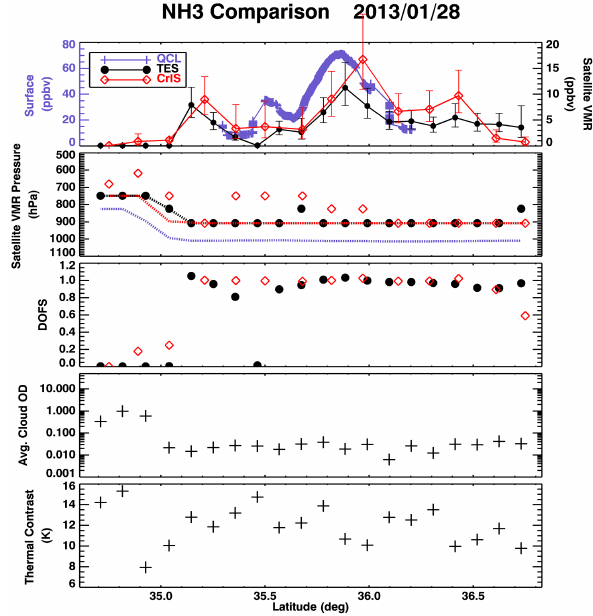
Figure 10. NH 3 measurements taken on 28 January 2013 in the San Joaquin Valley in California. The top panel shows surface mea- surements by the Open Quantum Cascade Laser (QCL) (purple), which are averaged over the coincident TES footprint, and the satel- lite 900hPa values from the TES transect observations (black) and the corresponding closest CrIS footprints (red) with total error bars. The symbols in the second panel show the pressure of peak sensitiv- ity for the satellite observations, with the lines indicating the pres- sure level of the comparison values shown in the top panel ( ∼ 1km). The third panel contains the information content from the retrieval in terms of degrees-of-freedom for signal (DOFS). The last two pan- els show the atmospheric conditions in terms of cloud optical depth (COD) and thermal contrast (surface –